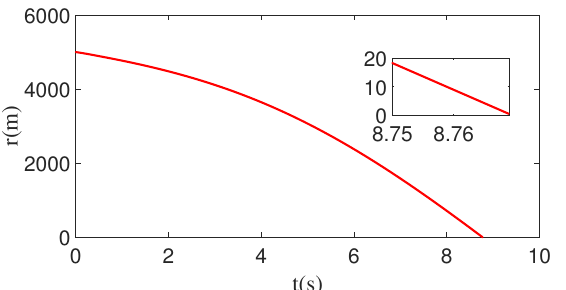
Figure 11. Time evolution of the relative distance between the missile and the target with white noise and constant maneuver.